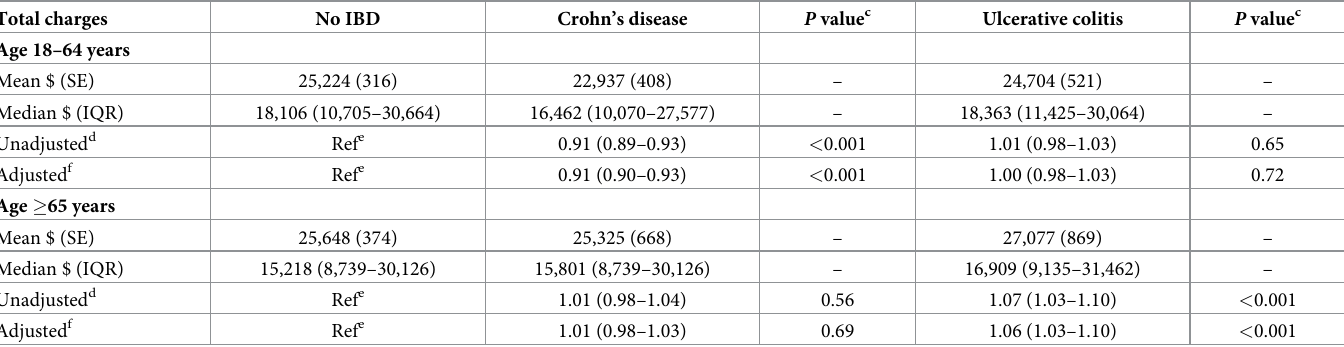
Table 3. Total charges a for major in-scope b ambulatory surgery encounters by age and status of inflammatory bowel disease,